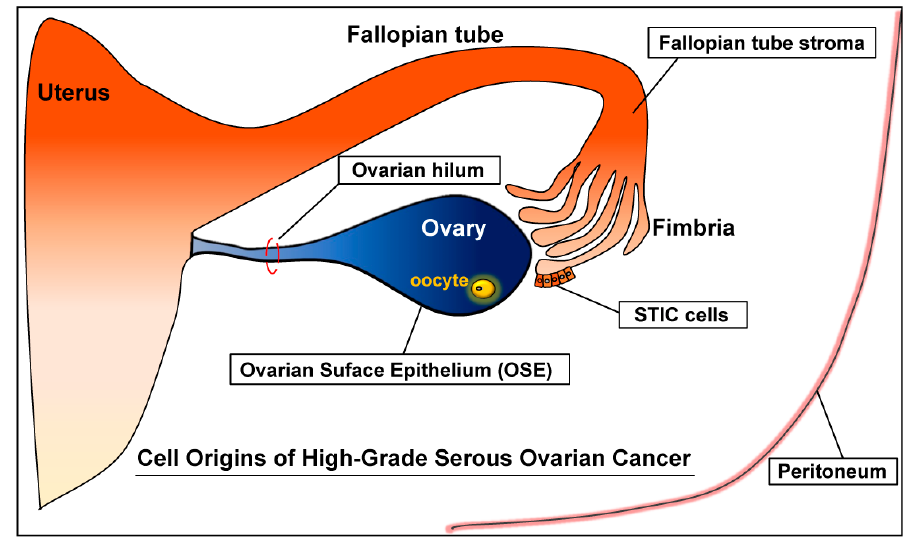
Figure 1. Cells of origin for high-grade serous ovarian cancer (HGSC).